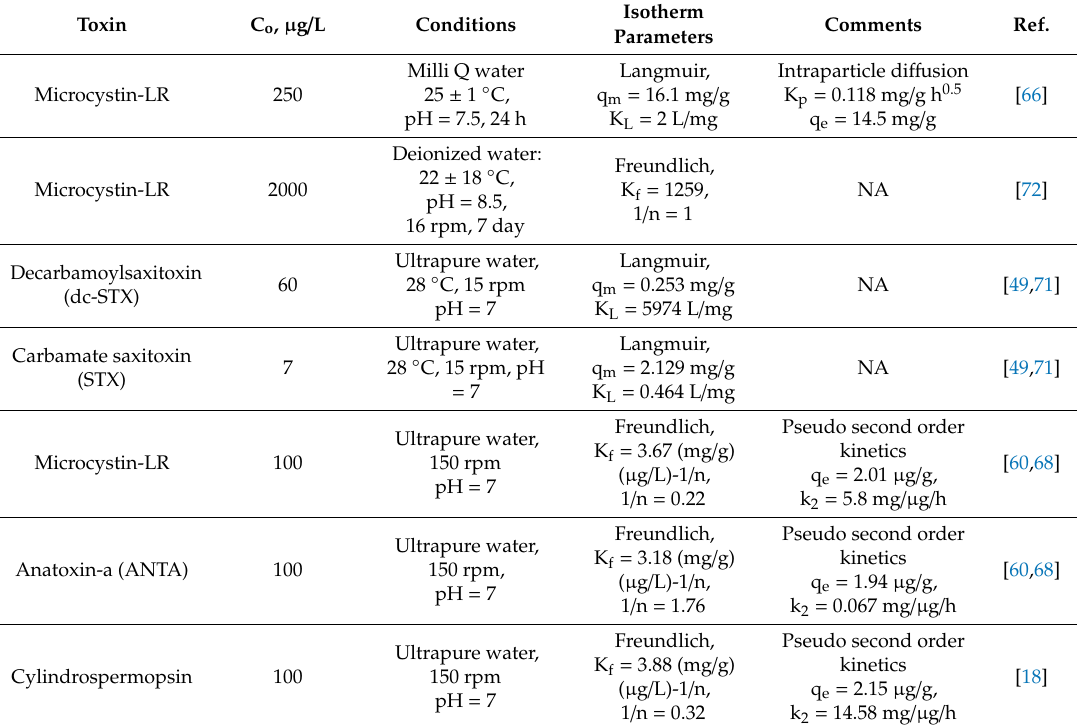
Table 4. The adsorption kinetics and isotherm parameters for di ff erent coconut-based granular activated carbon (GACs) and powdered activated carbon (PACs).